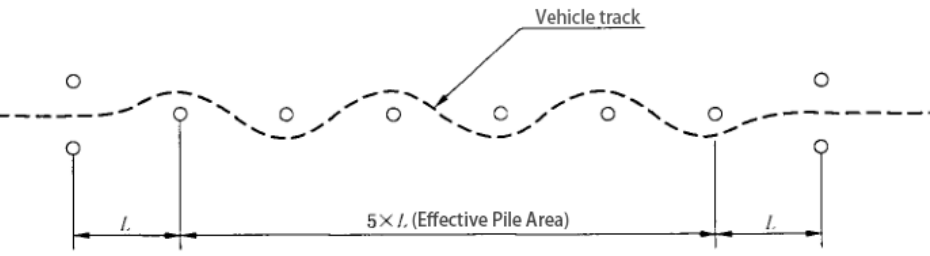
Figure 11. Pile-arrangement diagram of snake test.